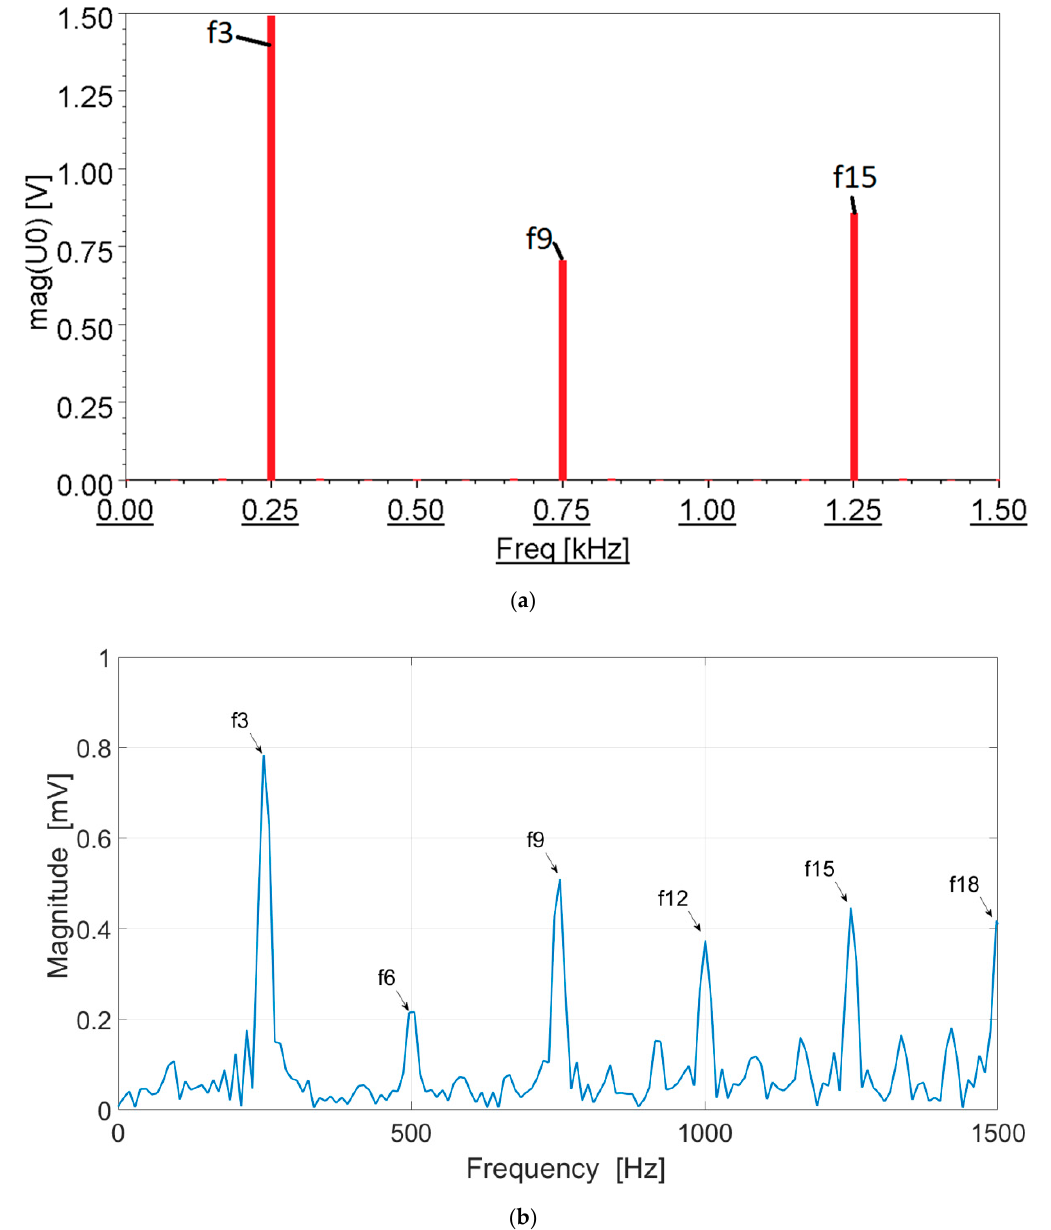
Figure 10. Fast Fourier Transform (FFT) of neutral voltage u 0 for star configuration in healthy mode: ( a ) numerical calculations; ( b ) measurements.